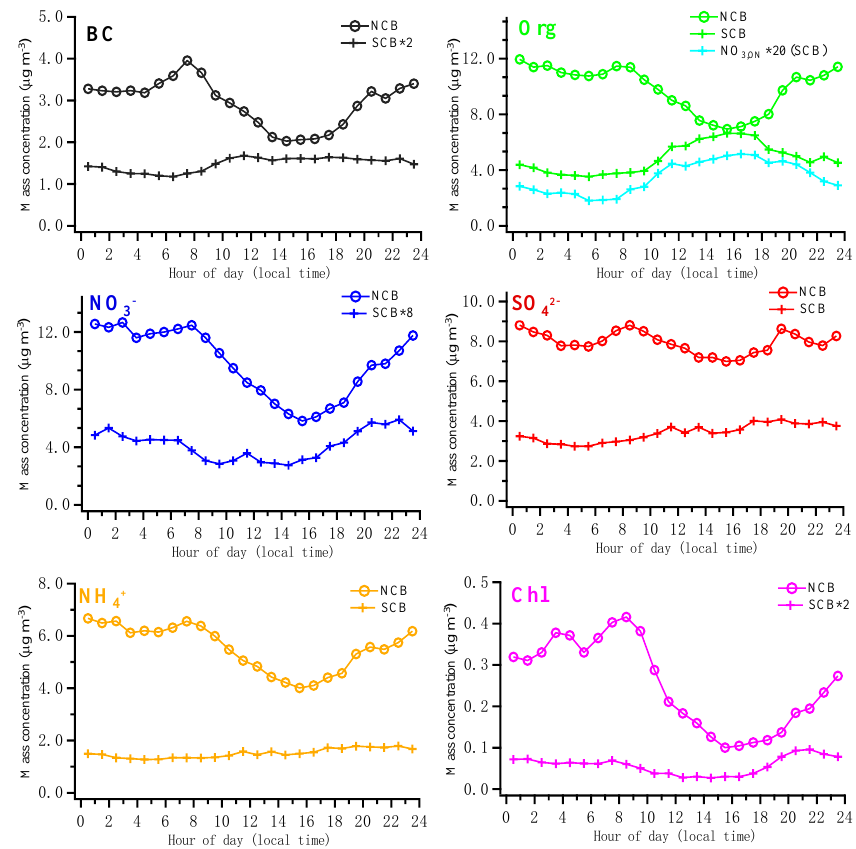
Figure 4. Diurnal variations in PM 1 components at NCB and